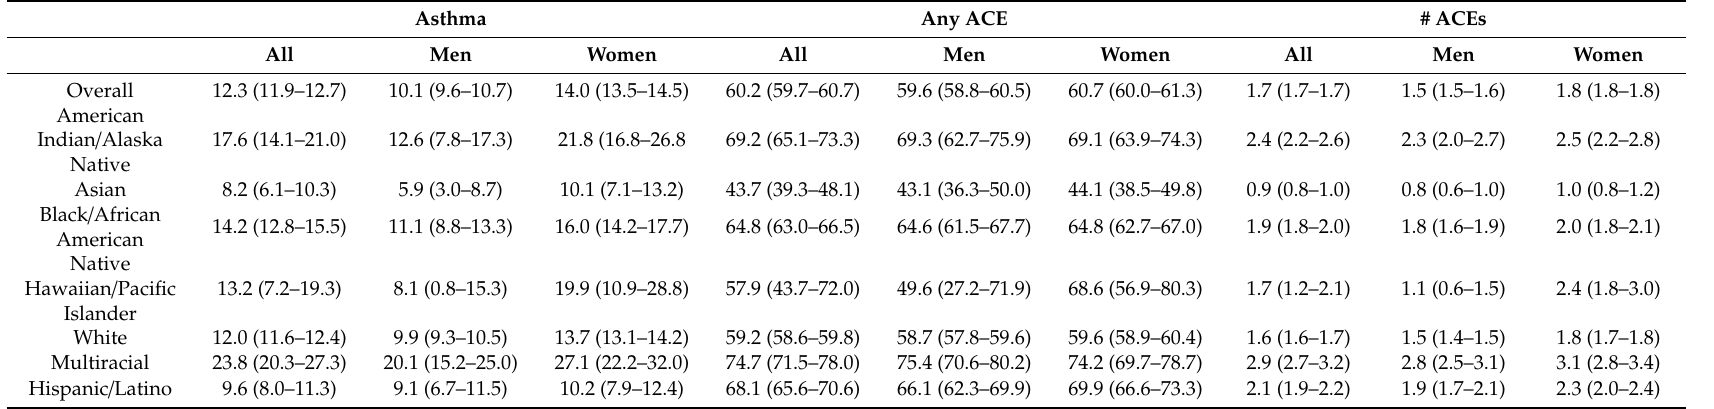
Table 3. Survey prevalence estimates (% or mean, 95% Confidence Interval) for asthma and adverse childhood experiences, overall and stratified by sex and race or ethnicity, calculated using Behavioral Risk Factor Surveillance System 2009–2012 data, N =